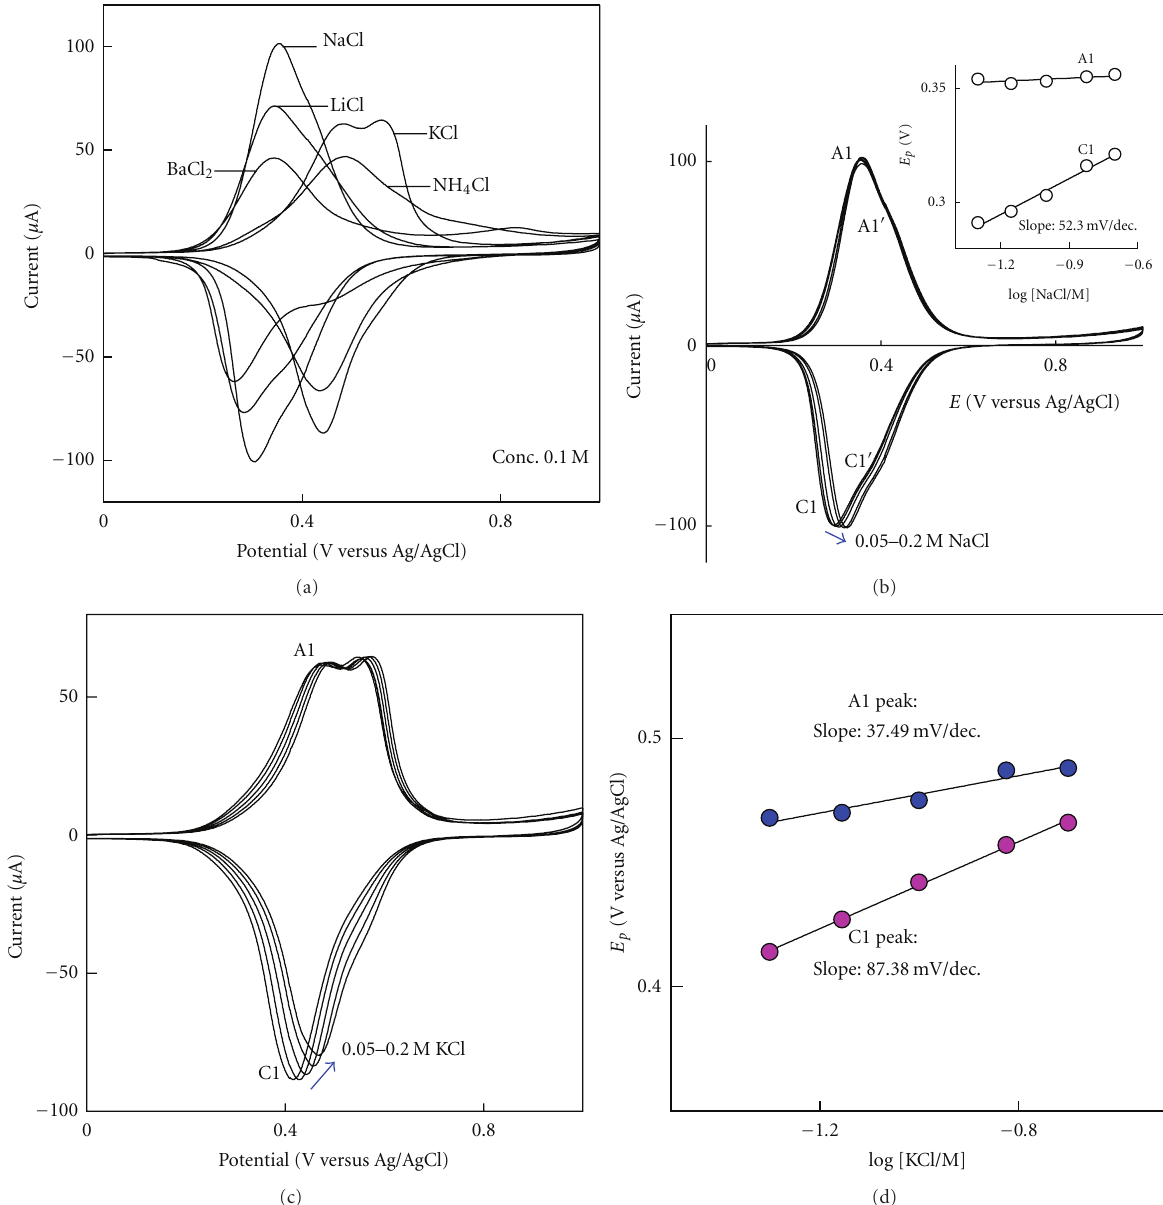
Figure 4: CV responses of GCE/NiHCFe@GMC at di ff erent (a) alkali metal ions and e ff ect of (b) Na + and (c) K + concentrations at a scan rate of 50 mV/s. Figures 3(b) and 3(d) inset are typical E p versus log(alkali metal ion) plots.